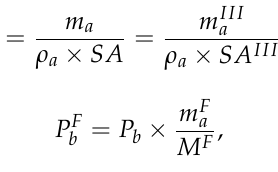
Passing of Medium III